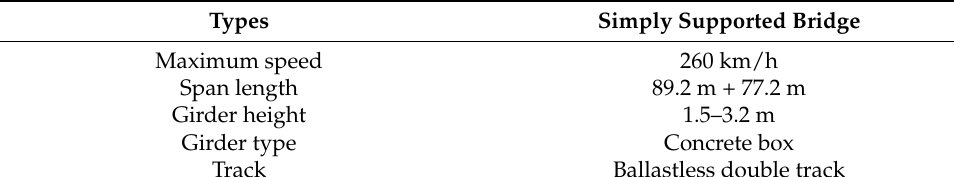
Table 4. Specifications of bridge B.